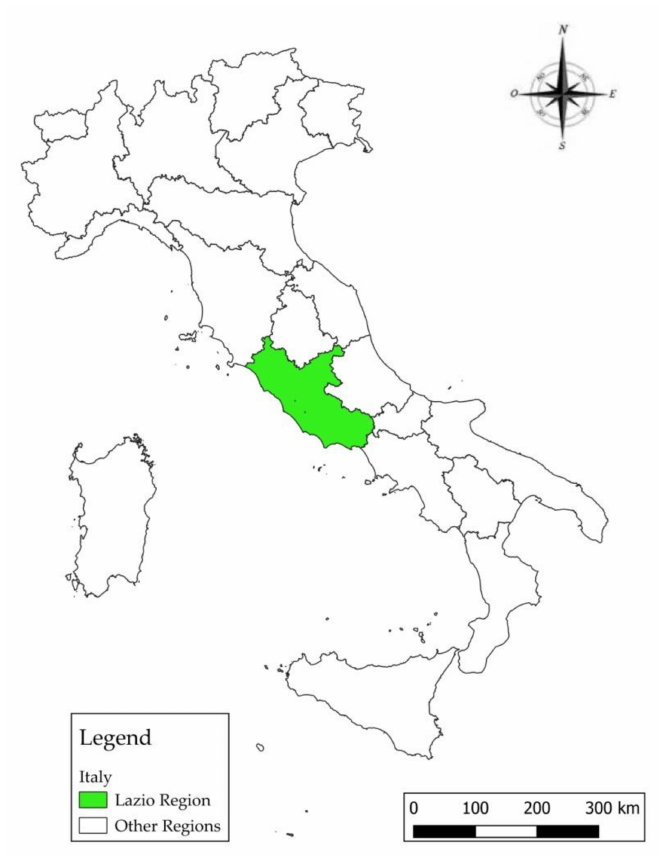
Figure 1. Lazio region